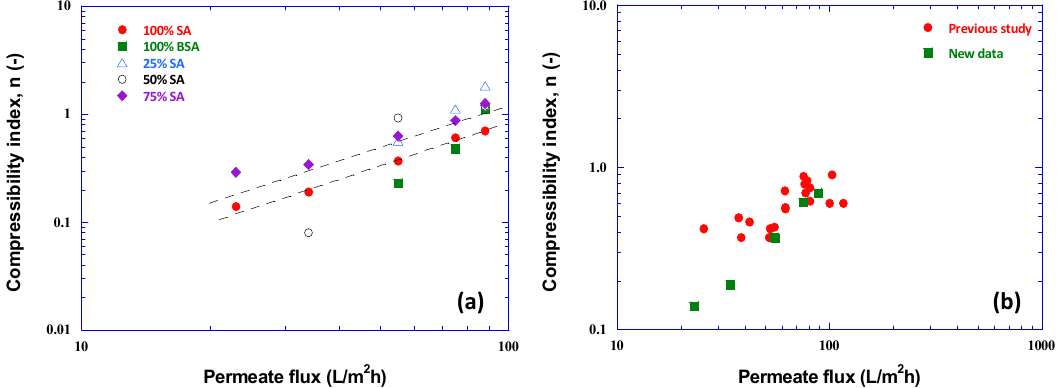
Figure 8. Compressibility index n values versus permeate flux. ( a ) Data from all tests with various foulant compositions; ( b ) comparison of data taken, with 100% SA foulants, in this and a previous study [31].